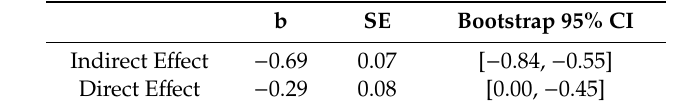
Table 4. Mediation model: mediating role of a ff ective commitment between entrepreneurial leadership and turnover intention.